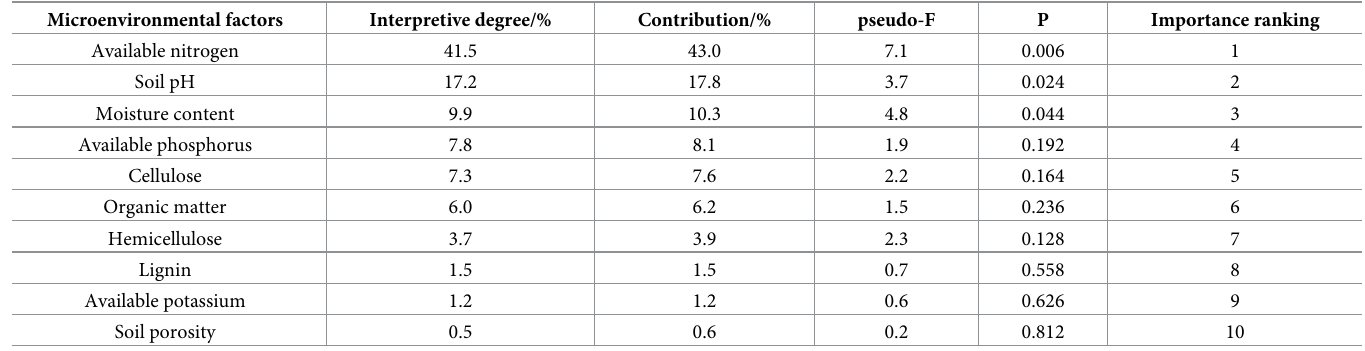
Table 3. Importance ranking and significance test